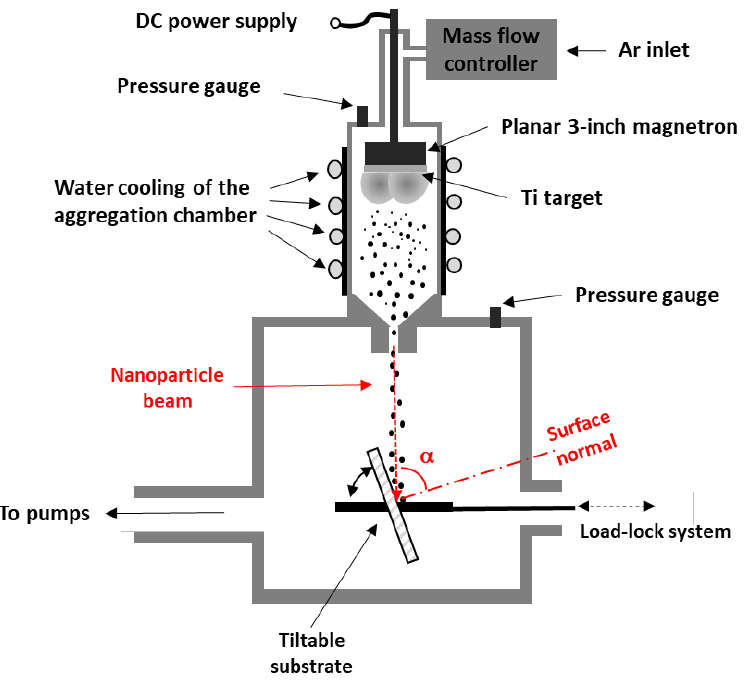
Figure 1. Schematic representation of the deposition set-up.